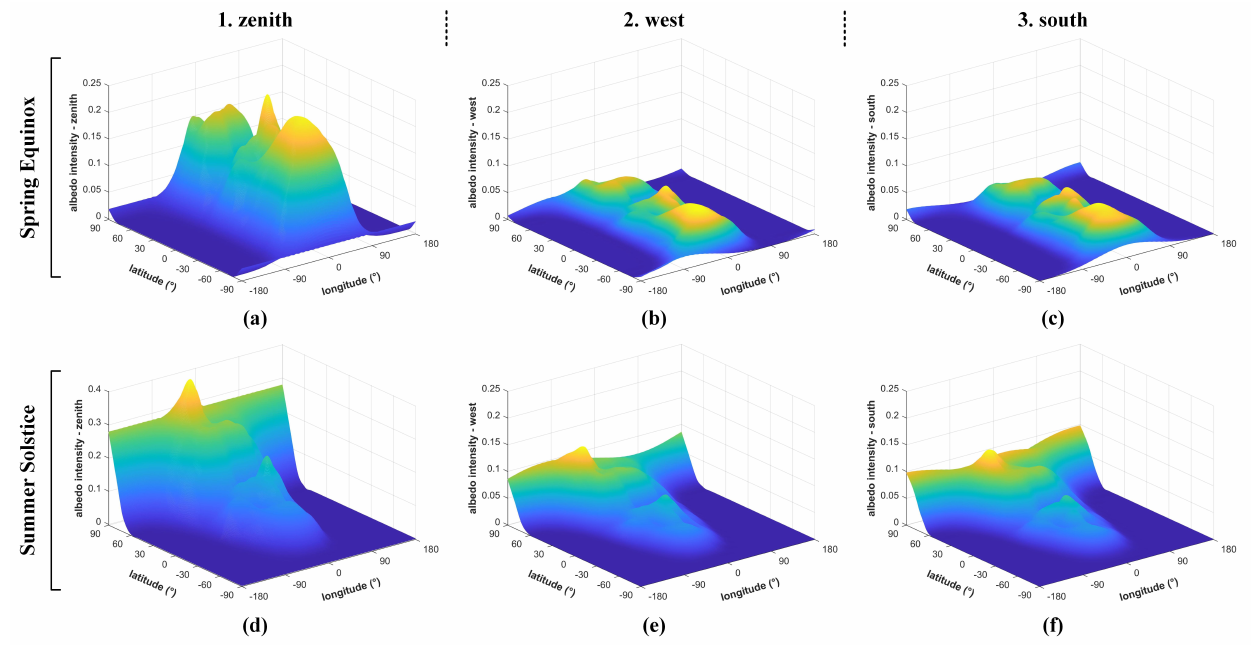
Figure 10. The albedo intensity in various directions normalized with respect to the solar constant at